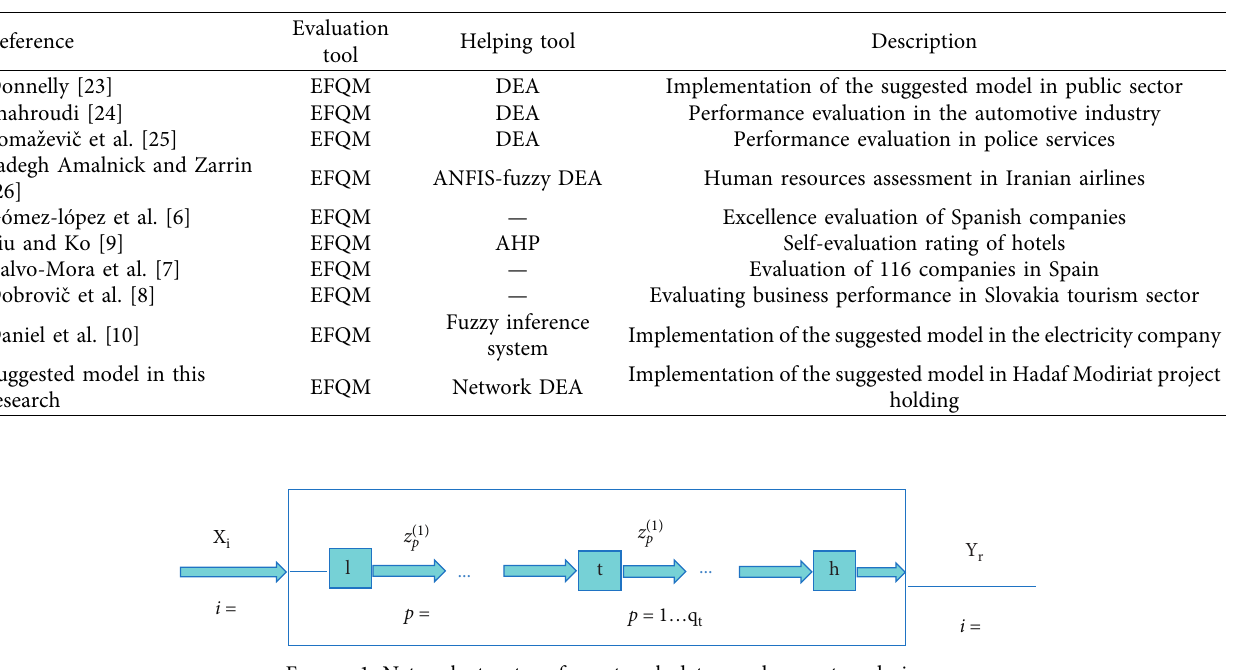
Table 1: Summary of the performed research studies concerning combination of EFQM excellence model and data envelopment analysis method.